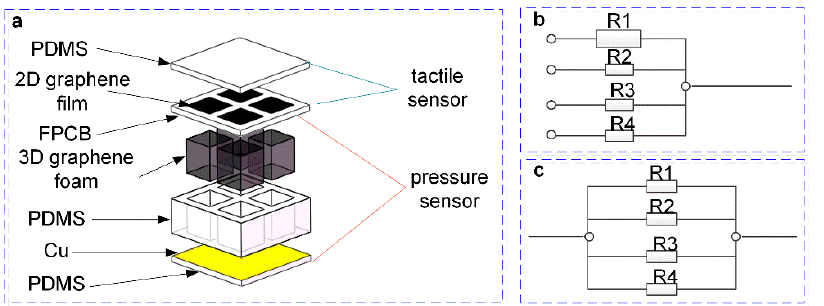
Figure 1. The structure of the designed sensor and measurement circuit schematic. ( a ) The structure of the designed sensor. ( b ) The measurement circuit schematic of the tactile sensor. ( c ) The measurement circuit schematic of the pressure sensor.